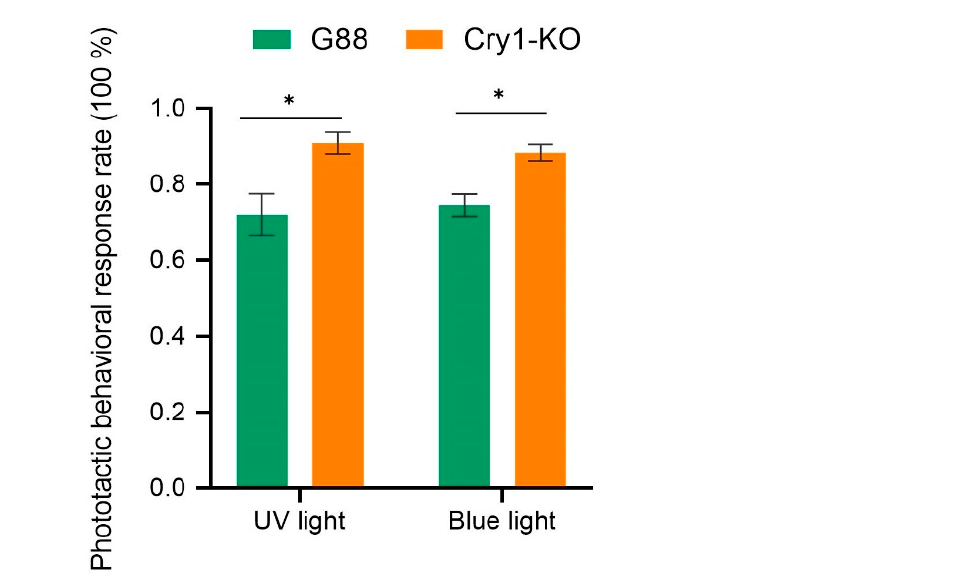
Figure 7. The influence of cry1 mutation on the phototaxis of P. xylostella male. “*” represents P < 0.05.